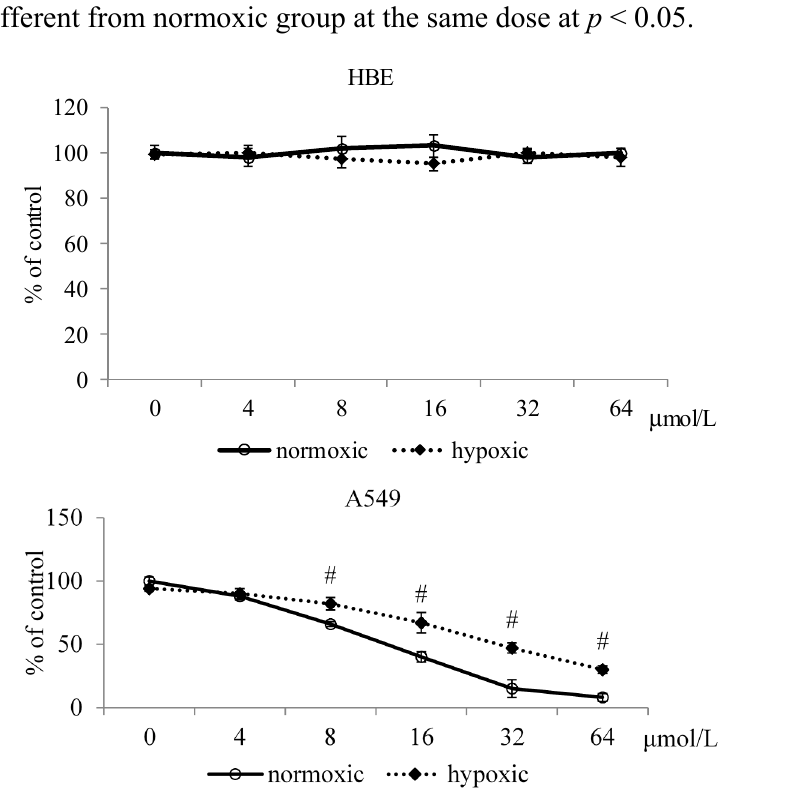
Figure 1. Effects of MA at 0, 4, 8, 16, 32 or 64 μ mol/L upon viability in HBE cells and A549 cells under normoxic and hypoxic conditions. Data are mean ± SD ( n = 10). #